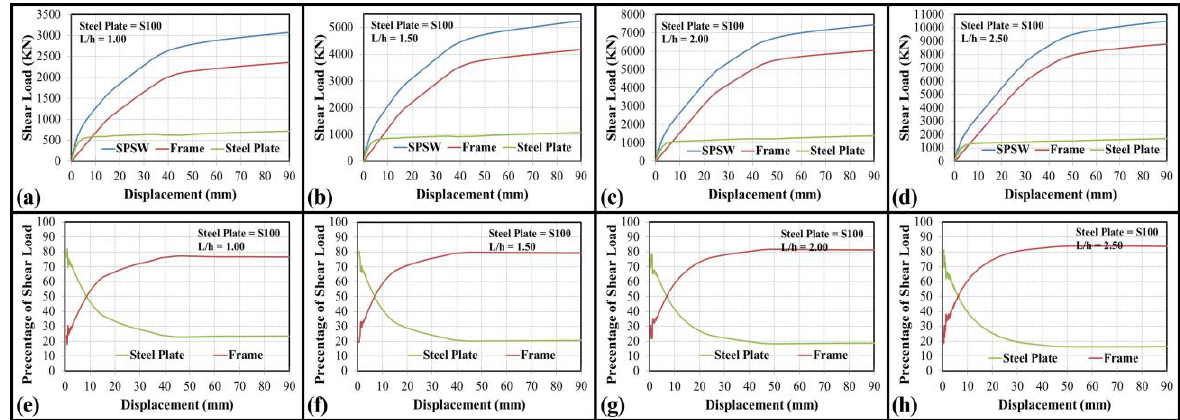
Fig. 7 . “Shear load-story drift” and “wall-frame interaction” curves of all SPSWs and moment frame using low-yield infill plate with different spans (3m, 4.5m, 6m, and 7.5m).